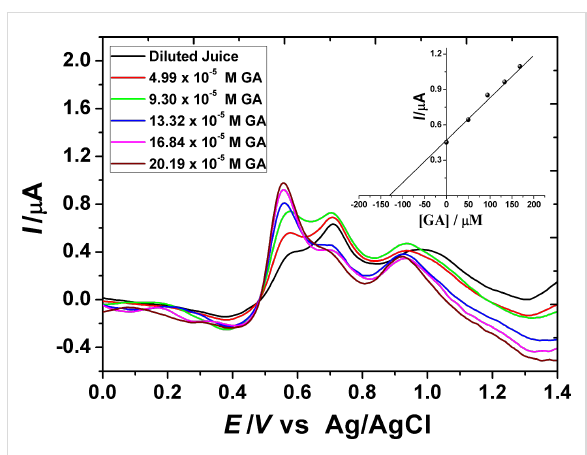
Figure 8: SW voltammograms obtained at optimal conditions of a pomegranate juice sample upon addition of different concentrations of GA for determination of TPC. Inset: the analytical